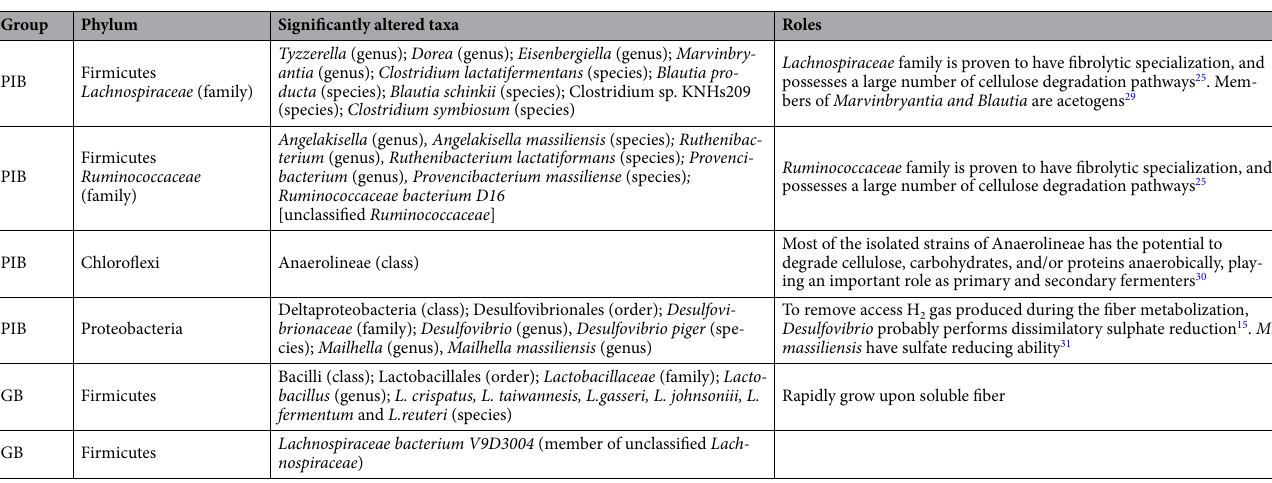
Table 1. The roles of significantly increased taxa in the PIB and GB diet groups shown in Fig. 3 in fiber degradation and other